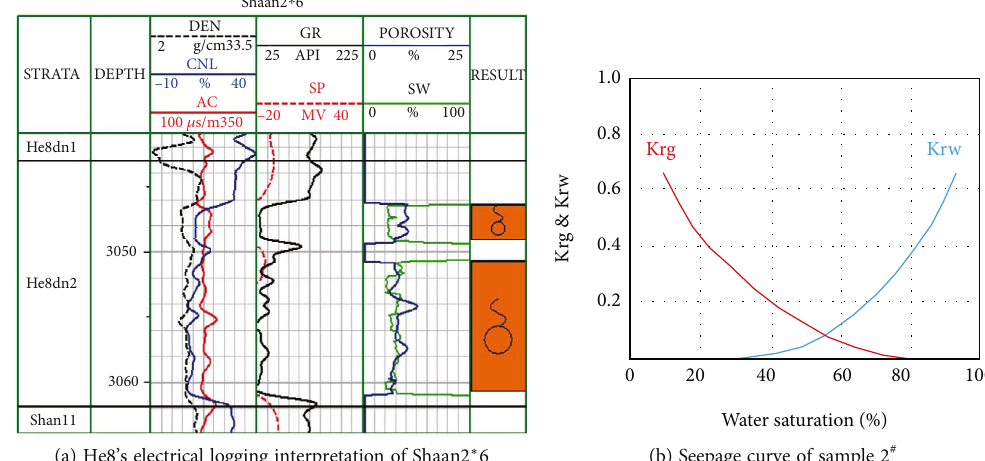
Figure 9: He8 ’ s electrical logging interpretation and seepage curve of Shaan2 ∗ 6. (a) He8 ’ s electrical logging interpretation of Shaan2 ∗ 6. (b) Seepage curve of sample 2 # .